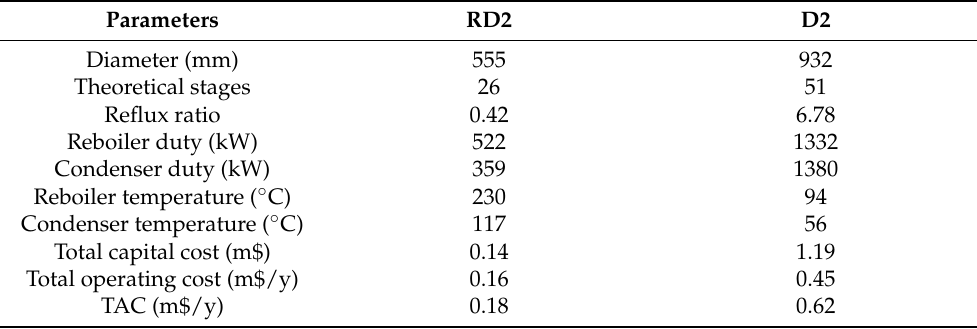
Table 4. Basis and details of equipment sizing for optimized pressure swing-based RD and DWC.